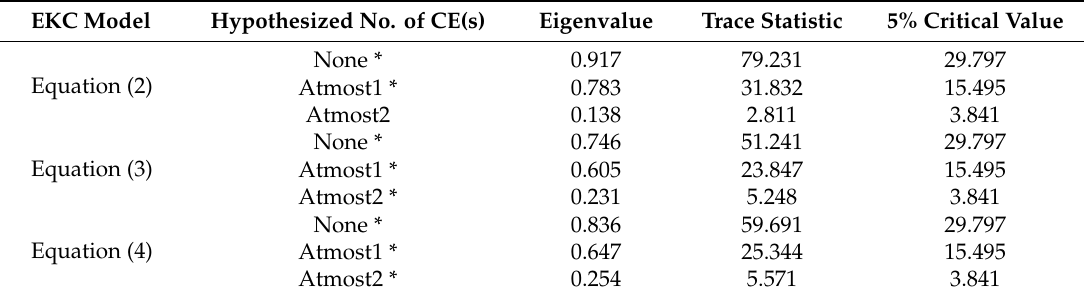
Table A1. The results of the Johansen cointegration